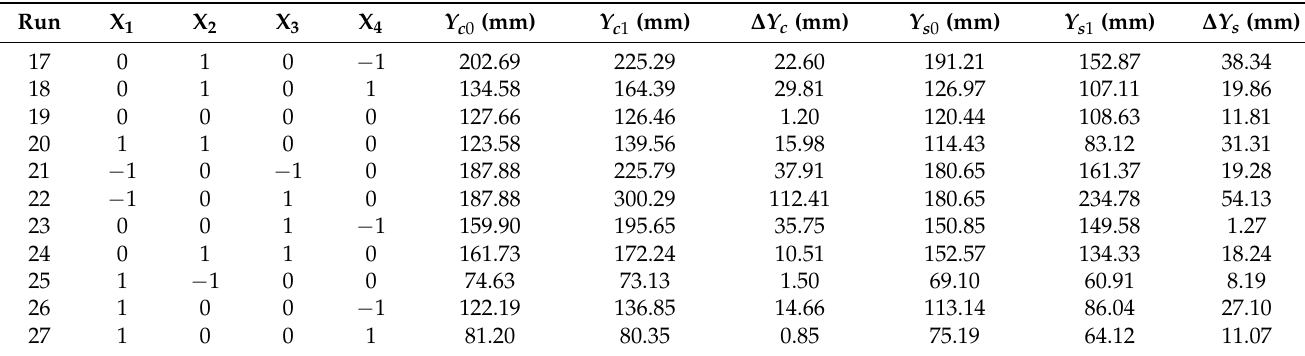
Figure 11. Effect of various factors on the longitudinal radius of the negative Gaussian curvature surface: ( a ) Maximum compression ratio; ( b ) Sheet width; ( c ) Sheet thickness; ( d ) Transverse curvature radius. 4. Correction and Verification of the Formulas for Longitudinal Curvature Radius 4.1. Correction of the Formulas Since the longitudinal exit velocity does not conform to a standard linear distribution, the longitudinal radius of the positive Gaussian curvature surface is larger than the calcu- lated value of Equation (9), and the longitudinal radius of the negative Gaussian curvature surface is smaller than the calculated value of Equation (11). Therefore, it is considered to increase the correction coefficient on the basis of the original formulas, so that the formu- las can make the prediction more accurate. The longitudinal curvature radii of the 27 sets of tests obtained by the response surface method are compared with the calculated values, and it is found that the ratio between the two is close to a constant. Thus, the average value of the ratio is taken as the correction coefficient. After calculation, when the maxi- mum compression ratio is 0.04–0.08, the sheet width is 210–270 mm, the sheet thickness is 1.5–2 mm, and the transverse curvature radius is 800–1200 mm, the correction coefficient for the positive Gaussian curvature surface is 1.138, and that for the negative Gaussian curvature surface is 0.905. The formulas for calculating the longitudinal curvature radius of the positive and negative Gaussian curvature surfaces after the correction are as fol- lows: